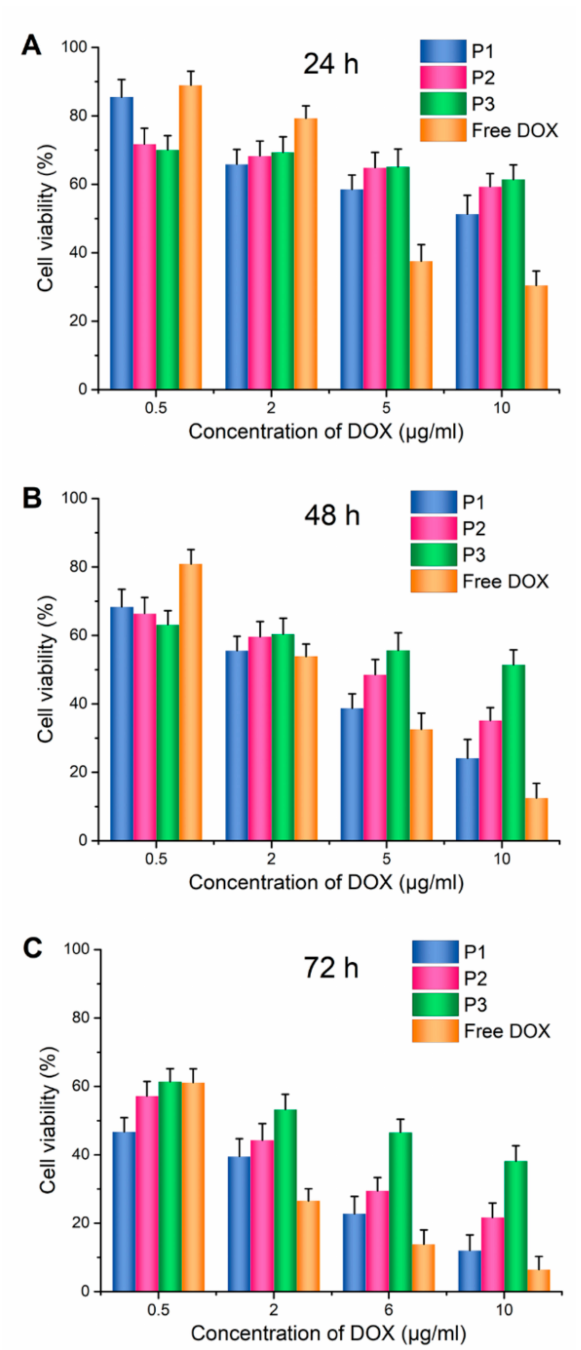
Figure 6. Cell viability of 4T1 cells after incubation with P1, P2, P3, and free DOX for 24 h ( A ), 48 h ( B ), and 72 h ( C